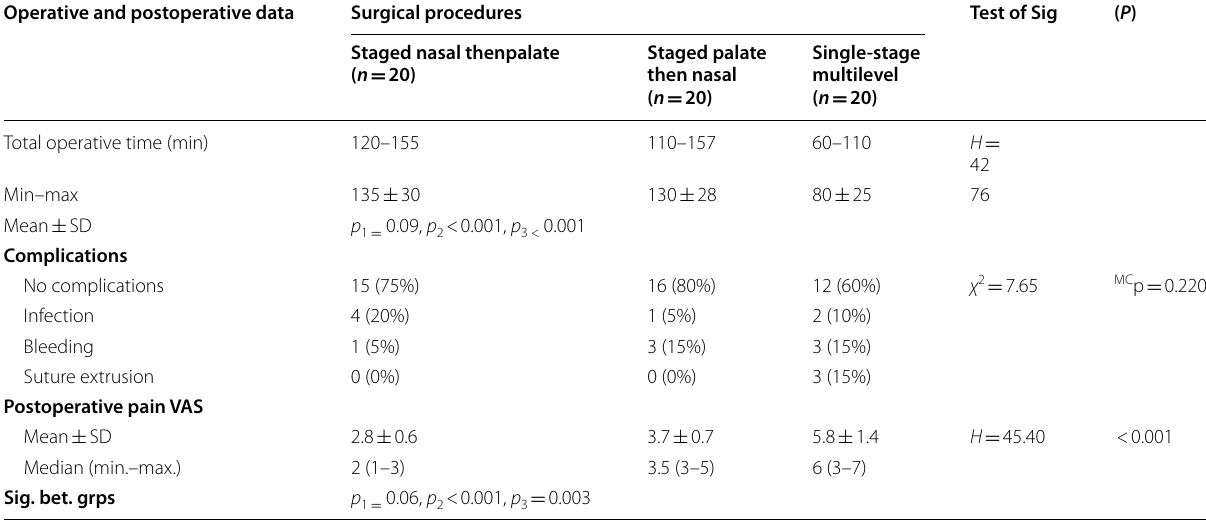
Table 5 Total operative time, postoperative complications, and pain (VAS) in OSA patients who underwent staged and single‑stage multilevel